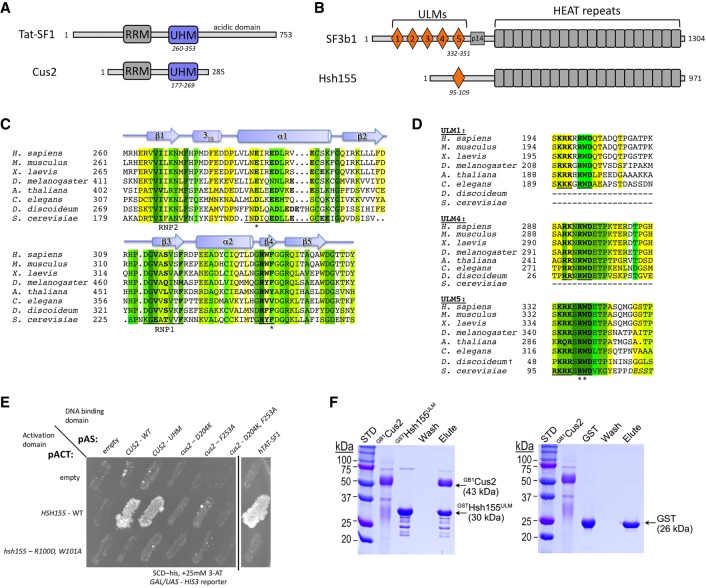
A putative UHM–ULM interaction between the U2 snRNP proteins Cus2 and Hsh155. (A,B) Domain organizations of (A) Tat-SF1/Cus2 and (B) SF3b1/Hsh155. (C) The sequences of the UHM region of Cus2 (Saccharomyces cerevisiae, NCBI RefSeq NP_014113) aligned with homologs including human Tat-SF1 (NCBI RefSeq NP_001156752), Mus musculus (NCBI RefSeq NP_083647), Xenopus laevis (NCBI RefSeq NP_001083090), Drosophila melanogaster (NCBI RefSeq NP_649313), Arabidopsis thaliana (NCBI RefSeq NP_197130), Caenorhabditis elegans (NCBI RefSeq NP_490765), and Dictyostelium discoideum (NCBI RefSeq XP_636172). The residues are colored by identity: <50%, white; 50%, yellow; 63%, chartreuse; 75%, lime; 88% green; 100%, forest. The Cus2 D204 and F253 residues mutated in this study are marked by asterisks. The Tat-SF1 UHM secondary structure elements assigned using the Kabsch and Sander algorithm are indicated schematically above the alignment (Kabsch and Sander 1983). Characteristic sequences of the UHM domain are underlined and bold. The ribonucleoprotein consensus motifs (RNP1 and RNP2) are underlined, and characteristic UHM residues that diverge from the RRM consensus are bold. (D) The sequences of the Hsh155 ULM (S. cerevisiae, NCBI RefSeq NP_014015) aligned with the ULMs of human SF3b1 (NCBI RefSeq NP_036565) that bind Tat-SF1 (ULM1, ULM4, and ULM5) and homologs including M. musculus (NCBI RefSeq NP_112456), X. laevis (NCBI RefSeq NP_001084150), D. melanogaster (NCBI RefSeq NP_608534), A. thaliana (NCBI RefSeq NP_201232), C. elegans (NCBI RefSeq NP_497853), and D. discoideum (NCBI RefSeq XP_643385). Matching ULMs were identified by BLAST (Altschul et al. 1990). The D. discoideum homolog appears to contain two rather than five ULMs, and Hsh155 contains a single ULM. Residues are colored by sequence identity as in C. Characteristic sequences of the ULM are underlined and bold. For the Hsh155 homolog, residues outside the boundary of the peptide used in this study are italicized, and the bound residues lack regular secondary structure elements. The Hsh155 R100 and W101 residues mutated in this study are marked by asterisks. (E) Yeast two-hybrid screen showing interaction between the UHM of Cus2 or Tat-SF1 and the ULM of Hsh155. Sequences encoding wild-type and mutant Cus2 proteins were fused to the DNA-binding domain of the GAL4 transcription factor and tested against constructs expressing either wild-type Hsh155 or mutant Hsh155 proteins fused to the activation domain of GAL4. Growth on SCD-His medium supplemented with 25 mM 3-AT indicates interaction. A black vertical line indicates that part of the plate was removed for clarity. (F) Cus2 directly and specifically binds the Hsh155 ULM region in GST pull-down assays. The retained proteins were resolved by SDS-PAGE and stained with Coomassie Brilliant Blue. The sizes of molecular weight standards (STD) and subunits are indicated. GST is a control for nonspecific binding. GB1Cus2 includes an N-terminal GB1-tag to improve solubility and reduce nonspecific binding to the resin. Hsh155ULM includes residues 86–129. The lanes are labeled: GB1Cus2, input Cus2; GSTHsh155ULM or GST, GST or GST-fusion protein used for bait; W, final wash of binding reaction; E, elution.